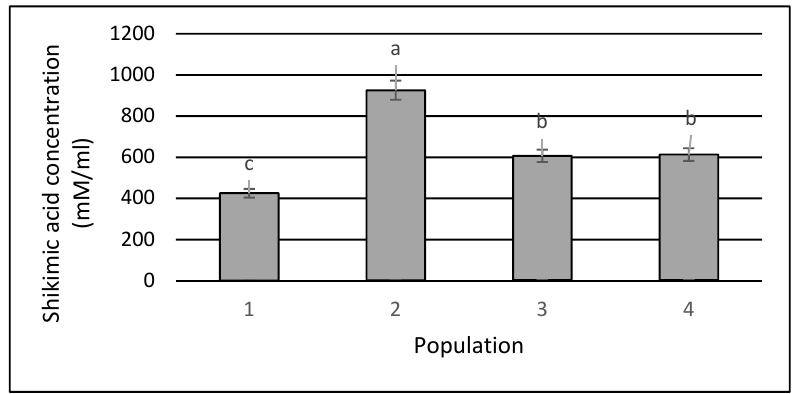
Figure 2. The different values of shikimic acid concentration for the four studied populations.